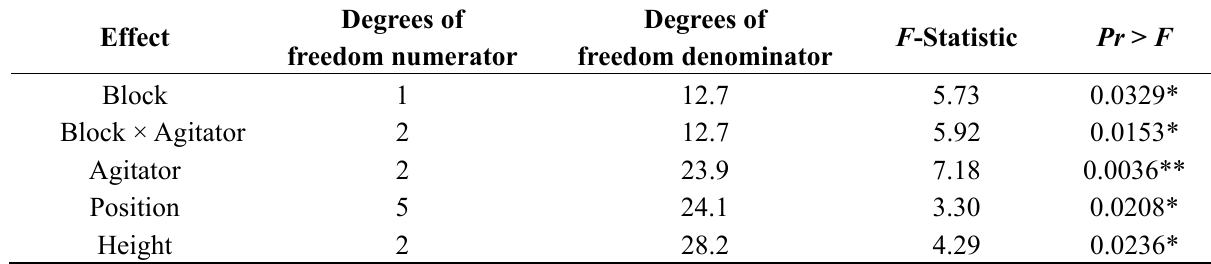
Table 4. Type 3 tests of fixed effects of acetic acid content on the reduced model. Degrees of Degrees Effect freedom numerator